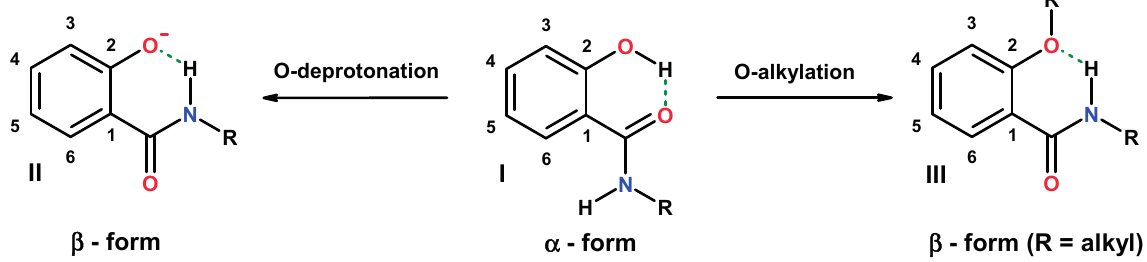
Figure 2. Chemically induced conformational switches of secondary salicylamides from the α - to the β -form (dashed lines: hydrogen bonding).